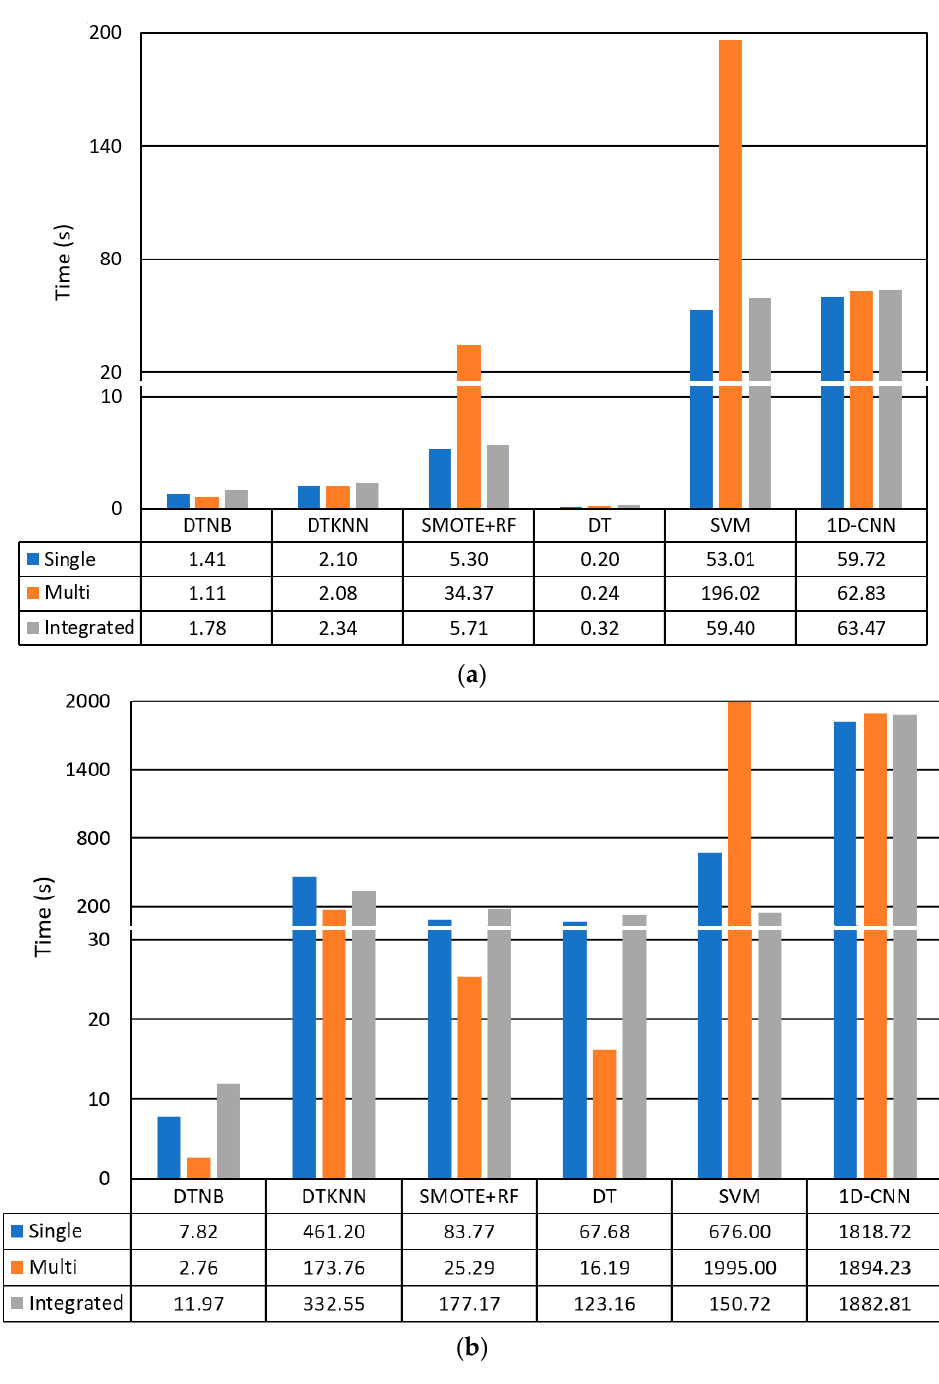
Figure 8. Each algorithm’s relative training and testing time according to each feature set. ( a ) Train- ing time. ( b ) Testing time. time. ( b ) Testing